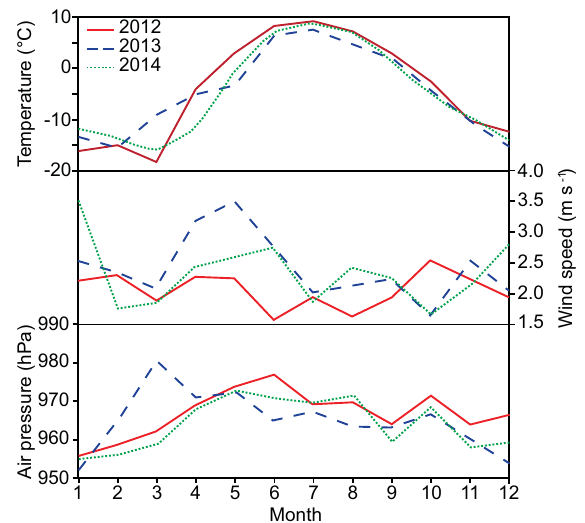
Figure 3. Mean monthly temperature, wind speed, and air pressure for Kangerlussuaq from 2012 (red solid line), 2013 (blue dashed line) and 2014 (green dotted line). Data from the Program for Mon- itoring of the Greenland Ice Sheet (PROMICE) and the Greenland Analog Project (GAP) were provided by the Geological Survey of Denmark and Greenland at http://www.promice.dk.